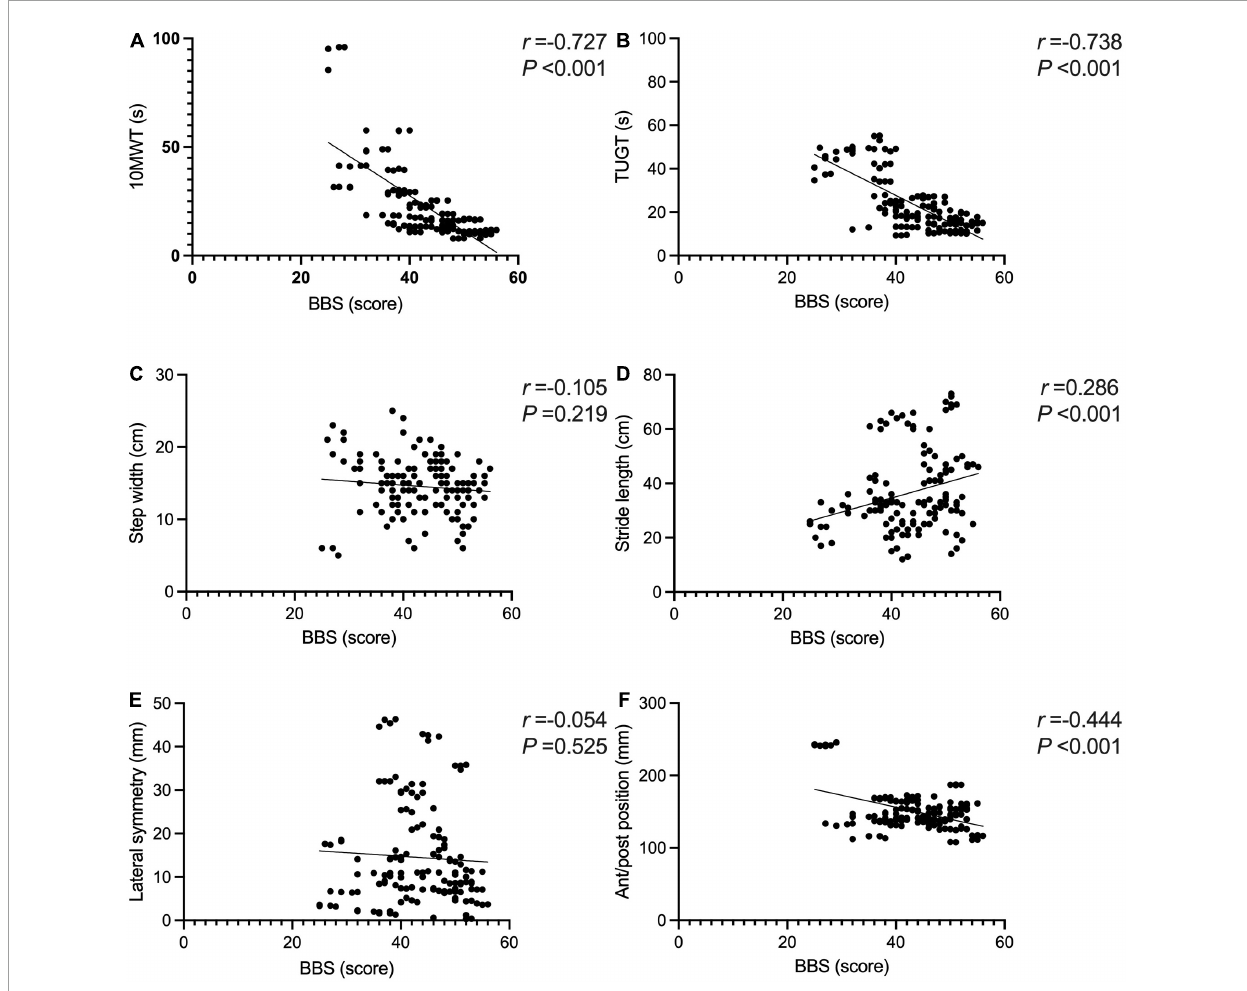
FIGURE7 Correlations between the Berg Balance Scale score and gait parameters in the study group. The BBS and the 10MWT had a negative correlation (A) ( r = − 0.727, P < 0.001). The BBS and the TUGT had a negative correlation (B) ( r = − 0.738, P < 0.001). The BBS score was not correlated with step width (C) ( P > 0.05). The BBS score was positively correlated with the stride length (D) ( r = 0.286, P < 0.001). The BBS score was not correlated with lateral symmetry (E) ( P > 0.05). The BBS score was negatively correlated with the ant/post position (F) ( r = − 0.444, P < 0.001). *Indicates significantly